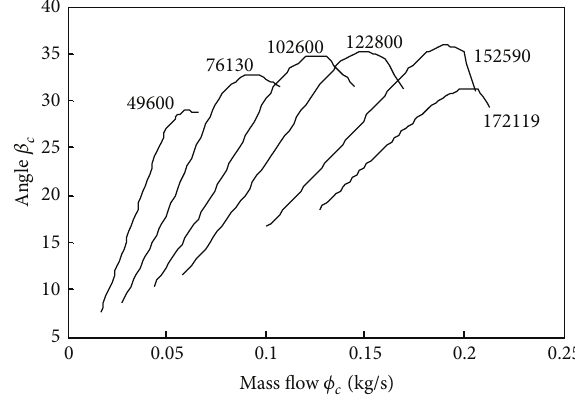
Figure 6: Optimal angle as parameter of compressor efficiency model.